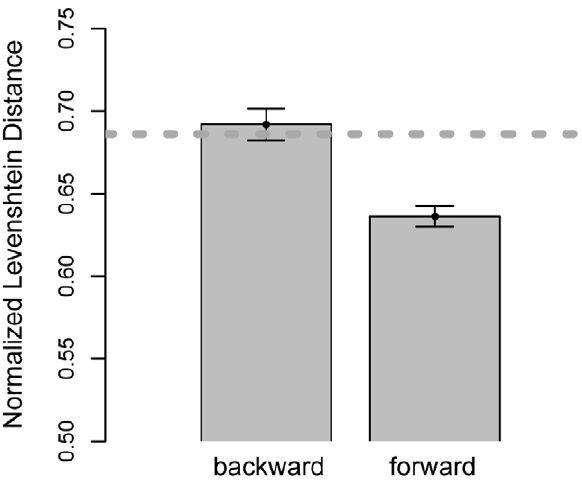
Figure 6. The average normalized Levenshtein distance between the observed sequence, on the one hand, and the closest of the set of predicted sequences, on the other hand. The dotted line is considered a baseline measure, which is the average normalized Levenshtein distance between an observed sequence and its randomized version. The error bars represent standard errors.